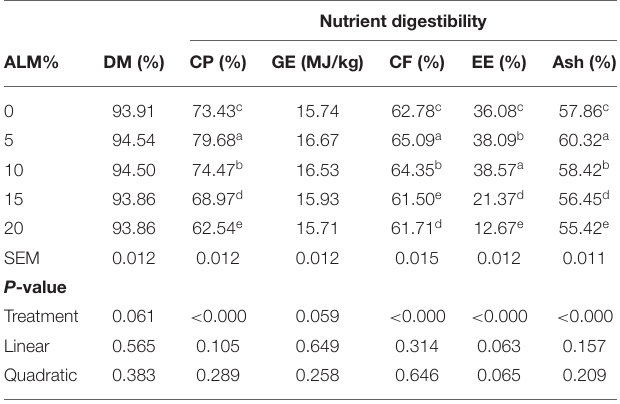
TABLE 6 | Effect of amaranth leaf meal inclusion on essential amino acids digestibility (%) of Ross 308 broiler chickens. Essential amino acid digestibility % ALM%